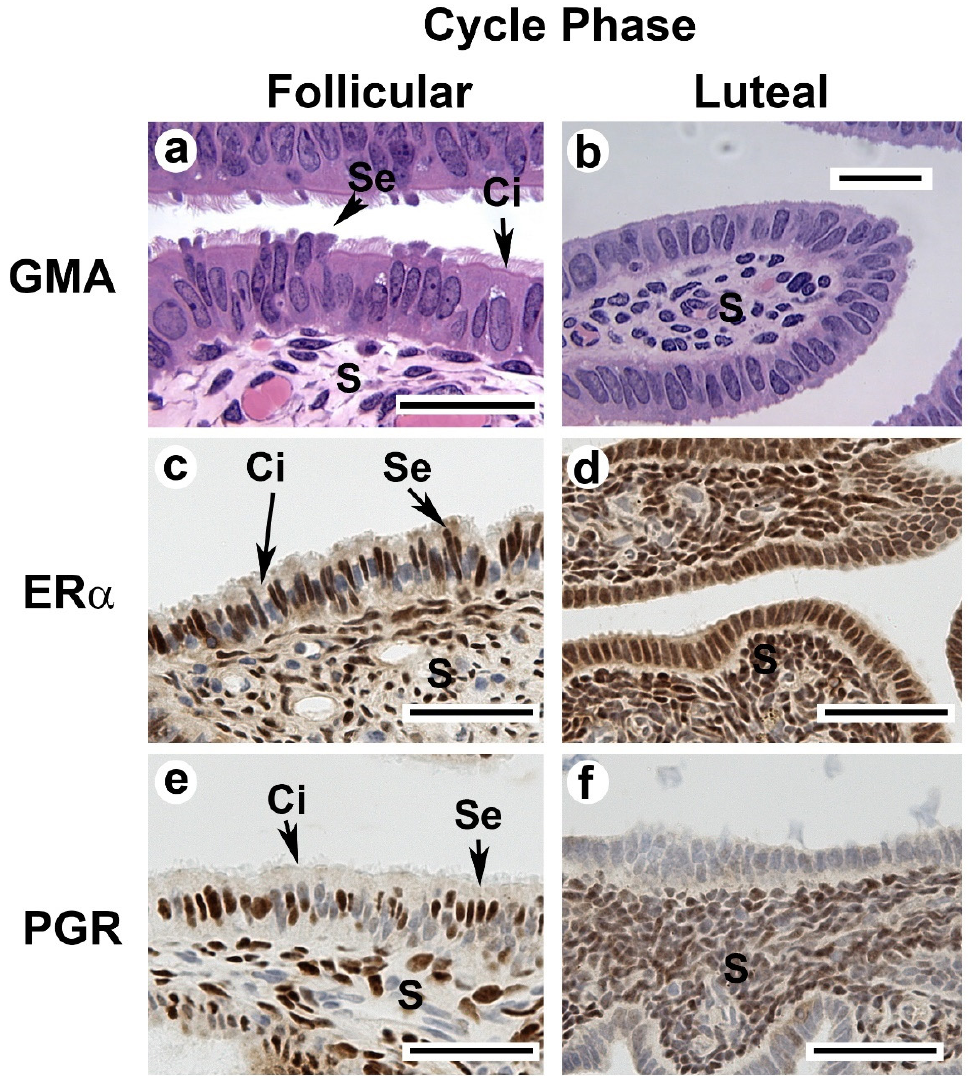
Figure 3. Photomicrographs of macaque oviductal fimbria collected in the follicular and luteal phases of the menstrual cycle. Glycol methacrylate sections stained with gills hematoxylin from the follicular phase ( a ) show differentiation into a fully secretory state. Luteal phase ( b ) is fully regressed (scale bars in ( a , b ) are 30 μ m). In the luteal phase, presentation of cilia and secretion are blocked by P 4 . Immunostaining for ER α ( c , d ) and PGR ( e , f ) in cryosections revealed that the ciliated cells had minimal receptor staining in the differentiated state, whereas secretory cells stained strongly for both ER α and PGR. In contrast, sections from the luteal phase have strong ER α staining in all the cell types, whereas PGR staining was lost from the epithelium and retained in the stroma (scale bar in ( c – f ) is 50 µ m). Together, this staining presentation implies that PGR regulation of oviductal differentiation may be indirect or mediated through non-classical mechanisms. Se = secretory cells; Ci = ciliated cells; S = stromal